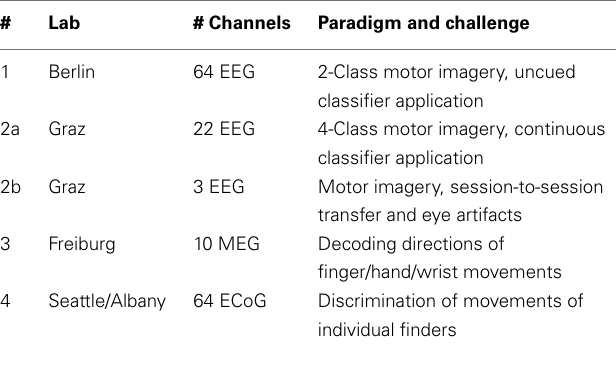
Table 1 | Overview of the data sets of BCI competition